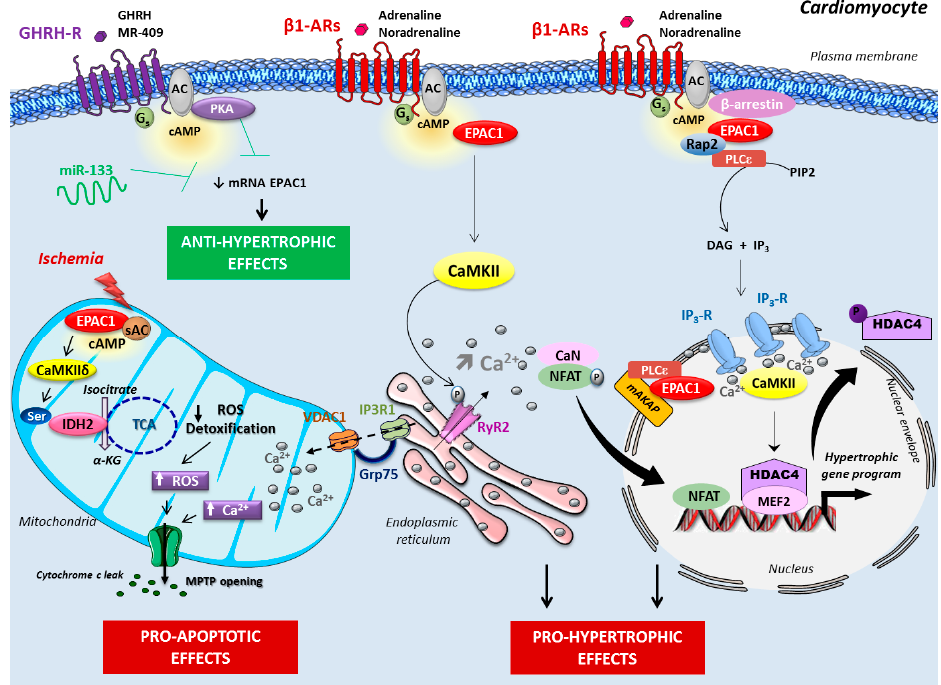
Figure 1. Epac signalosome in cardiac hypertrophy and ischemia. Under adrenergic stimulation, the Epac1– β -arrestin complex is recruited at the β 1 -AR, and activates a pro-hypertrophic signaling pathway. Epac1 is also scaffolded at the nuclear envelope with phospholipase C (PLC) ε and muscle-specific A-kinase anchoring proteins (mAKAP) to regulate the hypertrophic gene program. In the nuclear/perinuclear region, PLC ε increases nuclear Ca 2+ content via the activation of the perinuclear IP3 receptor (IP3-R). Epac1 hypertrophic signaling also involves CaMKII-dependent phosphorylation of RyR2, leading to Ca 2+ leak from the sarcoplasmic reticulum and subsequent calcineurin (CaN) activation. The anti-hypertrophic action of the growth hormone-releasing hormone (GHRH) or its agonistic analog, MR-409, involves the protein kinase A (PKA)-dependent inhibition of Epac1 expression. MicroRNA-133 (miR-133) is cardioprotective, and targets several components